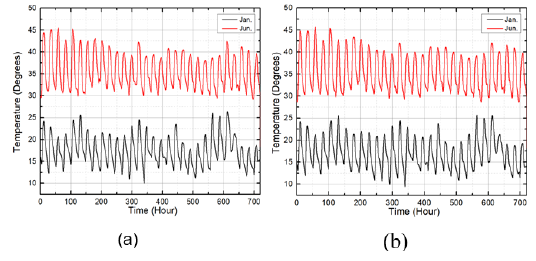
Figure 3. Temperature measured at height (a) 10m and (b) 2m, Dhahran 2018.